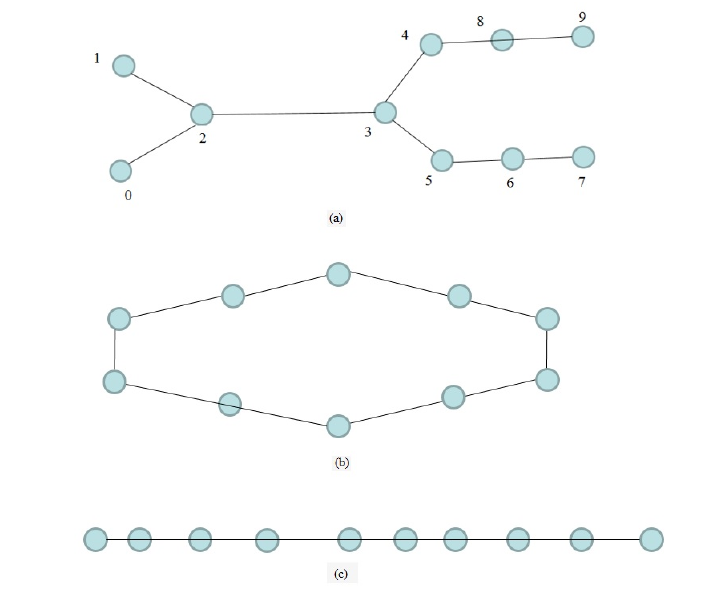
Figure 2. Weakly connected network: Three cases are shown in ( a ) tree form, ( b ) ring form, and ( c ) line